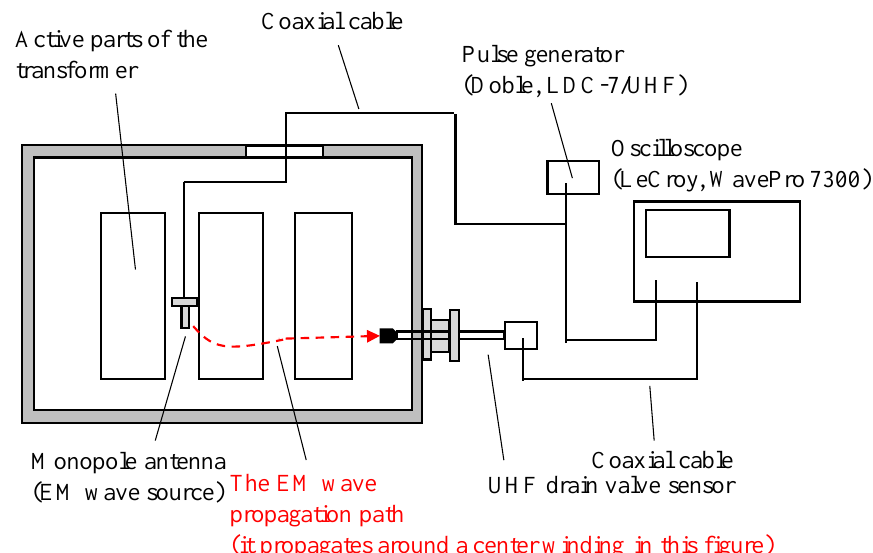
Figure 4. Measurement setup for propagation times of the EM waves.